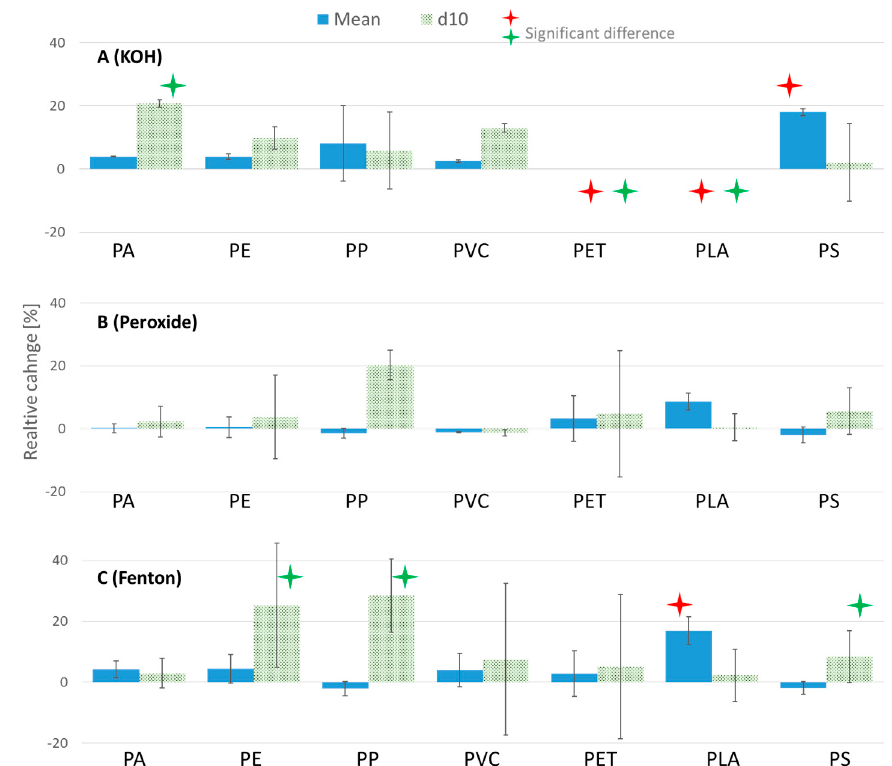
Figure 6. Relative particle size changes after treatment ( A ) KOH, ( B ) Peroxide, and ( C ) Fenton, compared to the controls (for weighted average sizes and 10th percentiles (d10)). The error bars represent the standard deviations. PLA and PET in (A ) were completely destroyed, thus no results are given. The red and green stars indicate statistical significance for the entire distribution, as well as d10, respectively.